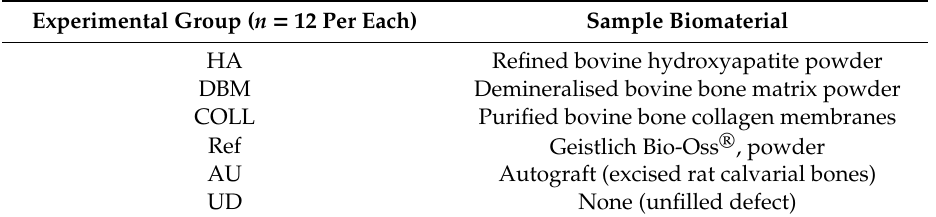
Table 1. Experimental